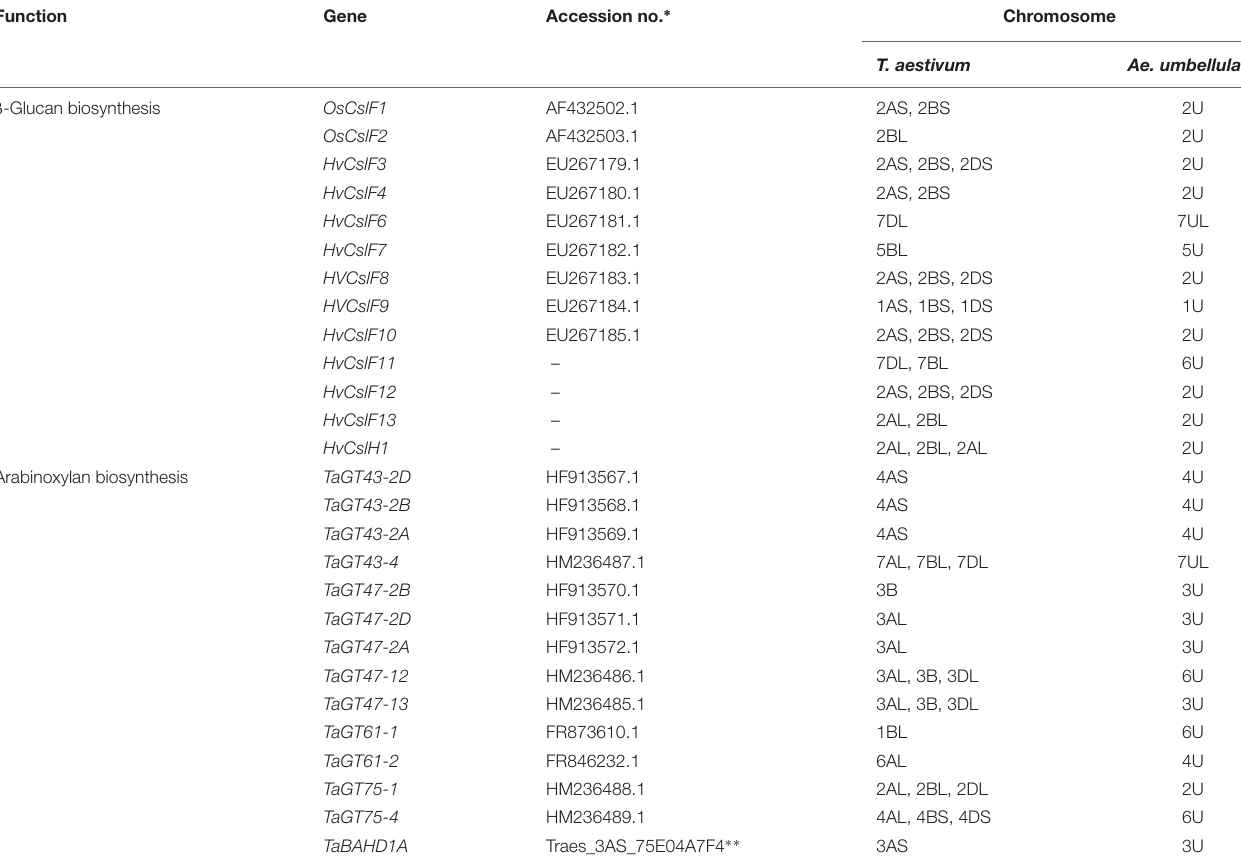
TABLE 2 | Chromosomal assignment of genes responsible for β -glucan and arabinoxylan biosynthesis in hexaploid wheat and Ae. umbellulata .